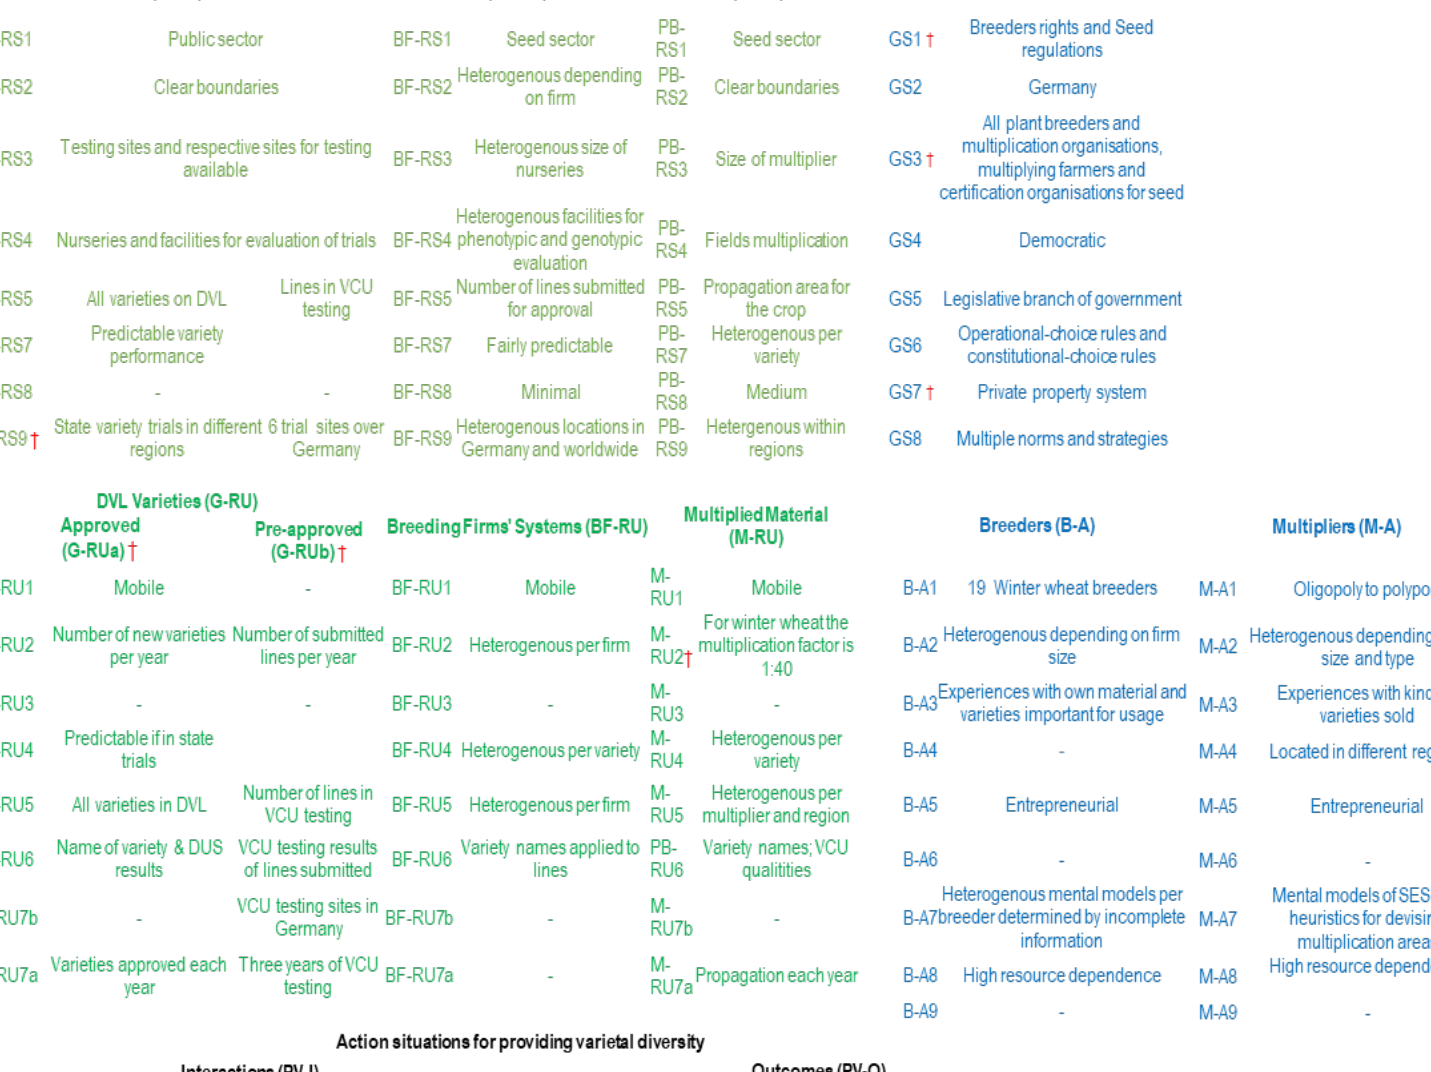
Figure A1.2: Second-tier